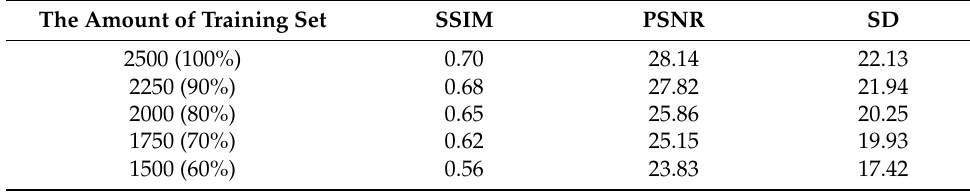
Table 9. Minimum training data experimental results.